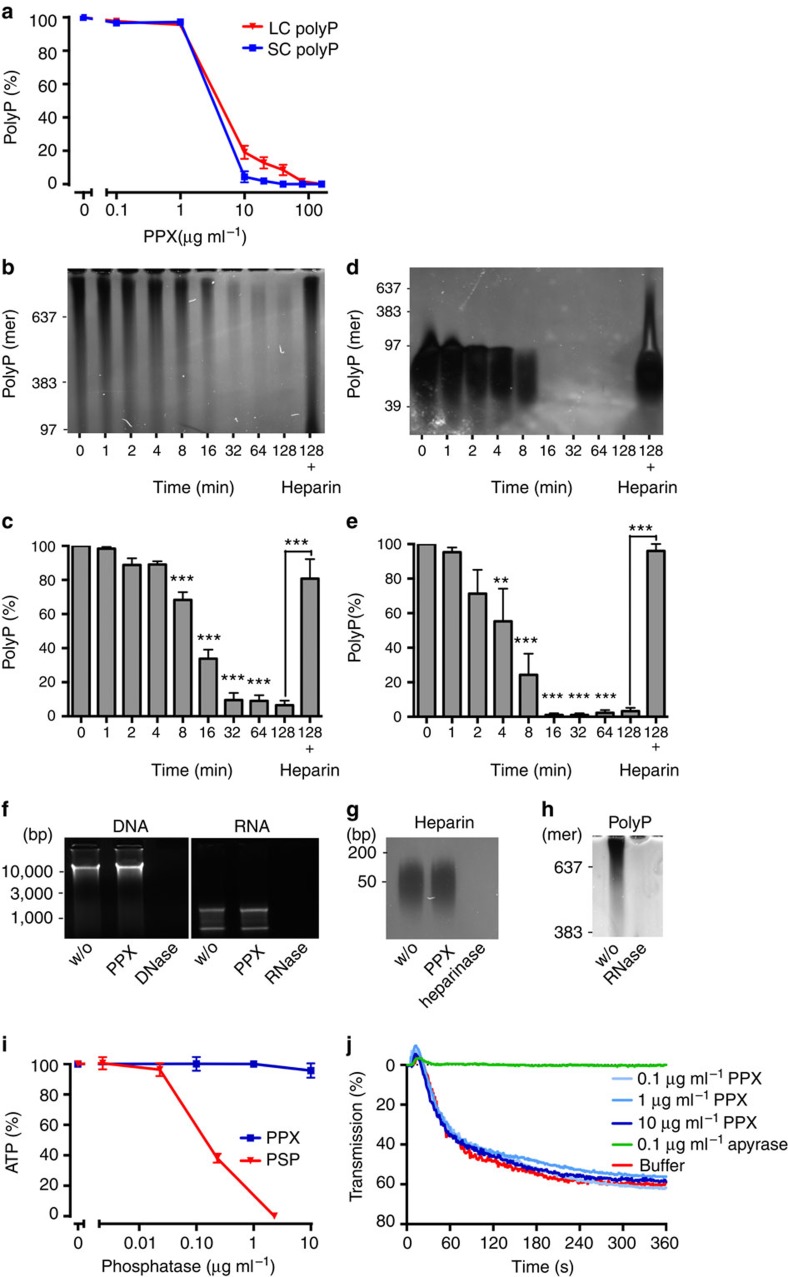
PPX specifically degrades polyP.Concentration- and time-dependent hydrolysis of LC and SC polyP by PPX. (a) LC and SC polyP (50 μg ml−1 each) were incubated for 30 min with PPX (0–160 μg ml−1). Reaction mixtures were separated on 10% urea-polyacrylamide gels, polyP was DAPI-negative stained and signals were blotted relative to buffer-treated polyP (100%). Mean±s.e.m., n=4. (b,c) LC and (d,e) SC polyP (50 μg ml−1 each) were incubated with 10 μg ml−1 PPX. Aliquots of 10 μl were taken at indicated time points, resolved on urea-polyacrylamide gels and visualized by negative DAPI staining. Synthetic polyP with mean chain length of 39, 97, 383 and 637 phosphates were loaded as molecular size standard. PolyP incubated with PPX in the presence of the inhibitor heparin (50 μg ml−1) is shown in the last lanes. Bars are mean±s.e.m., from four independent experiments, **P<0.01, ***P<0.001 versus 0 min by one-way analysis of variance (ANOVA) and by Student's t-test versus heparin addition. (f) DNA (1 μg) and RNA (1 μg) were treated with buffer (w/o), PPX (10 μg ml−1), DNase (0.1 mg ml−1) or RNase (0.5 mg ml−1) for 30 min, respectively, and resolved on agarose gels. (g,h) Heparin (10 μg ml−1) or polyP (50 μg ml−1) was treated with buffer (w/o), PPX (10 μg ml−1), heparinase I (1 U ml−1) or RNase (0.5 mg ml−1) for 30 min, respectively, separated on urea-polyacrylamide gels and negative DAPI stained. (i) ATP (1 μM) was incubated for 30 min with increasing concentrations of PPX (0–10 μg ml−1) or shrimp alkaline phosphatase (PSP, 0–2.3 μg ml−1) and quantified using a luciferase-based bioluminescence assay. Data are mean±s.e.m., from three independent experiments. (j) ADP (5 μM) was treated for 30 min with buffer, apyrase (0.1 U ml−1) or increasing concentrations of PPX (0–10 μg ml−1). Platelet aggregation in human platelet-rich plasma stimulated by the reaction mixtures. Representative curve of n=4.